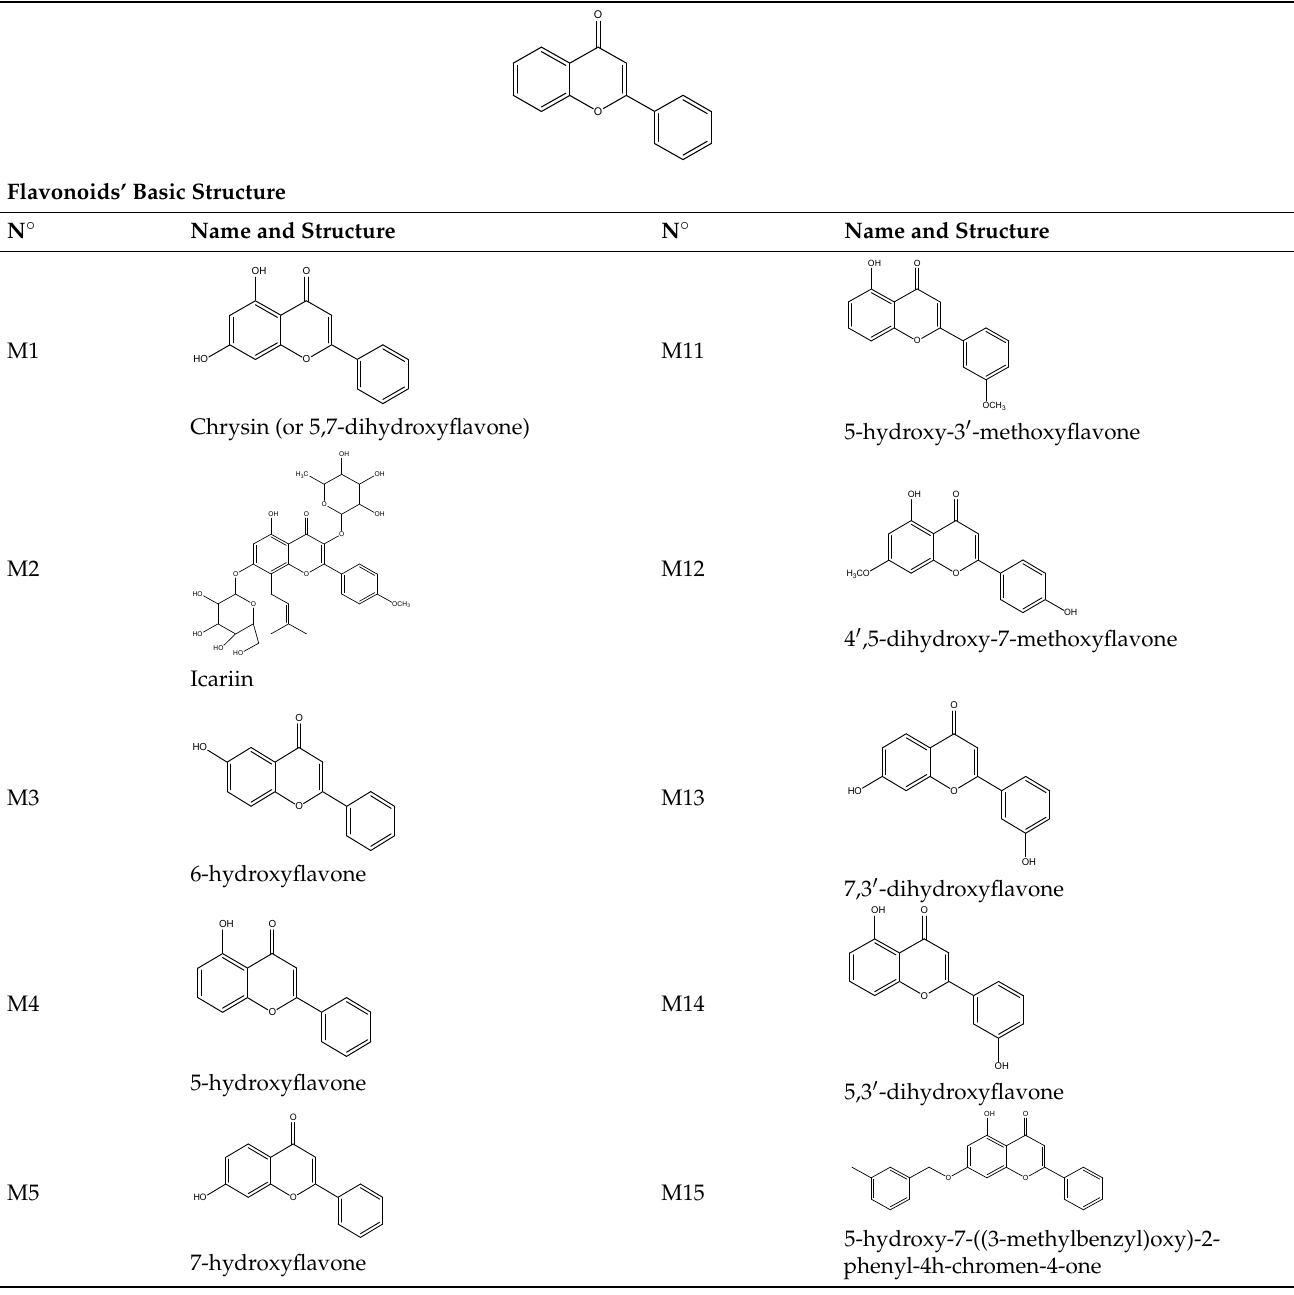
Table 1. The flavone structure list.